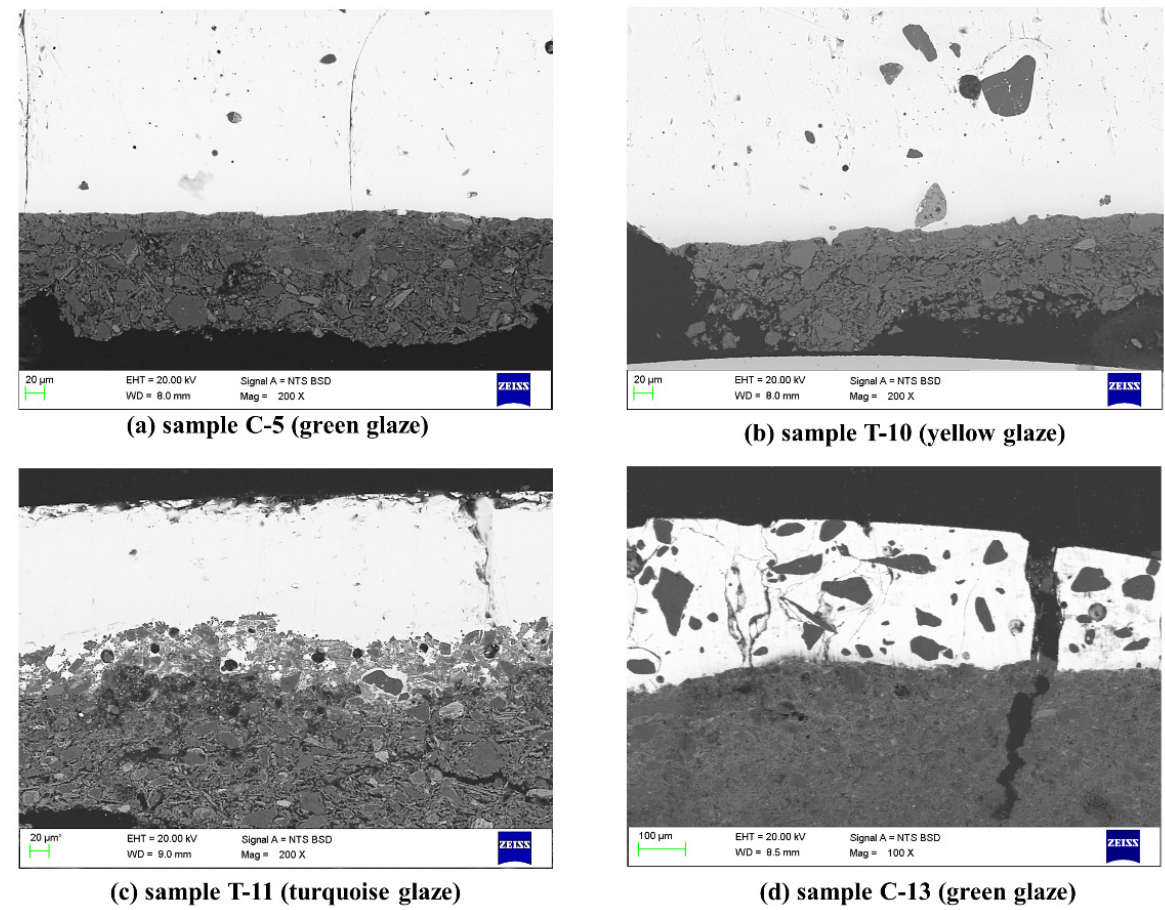
Figure 7. SEM backscattered electron mode images representative of glazed tile samples. ( a – c ) Glaze with a small number of quartz inclusions; ( d ) glaze with a large number of quartz particles.